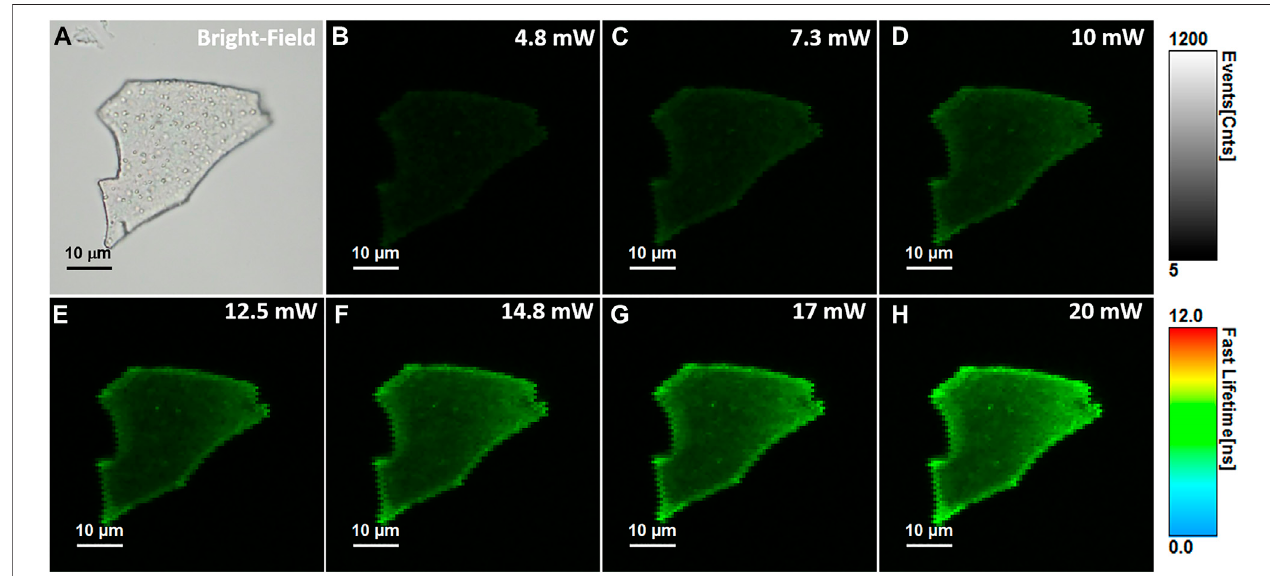
FIGURE 4 | (A) Optical image of the investigated BSA-AuNCs micro fl ake powder. (B – H) TPE FLIM images of BSA-AuNCs micro fl ake powder obtained under 810 nm excitation and different laser power ranging from 5 to 20 mW at the exit of the laser cavity. All FLIM image are presented to the same intensity (0-1,200 counts) and lifetime (0 – 12 ns) scales. The images were recorded at a resolution of 128 × 128 px with an imaging speed of 49 s.